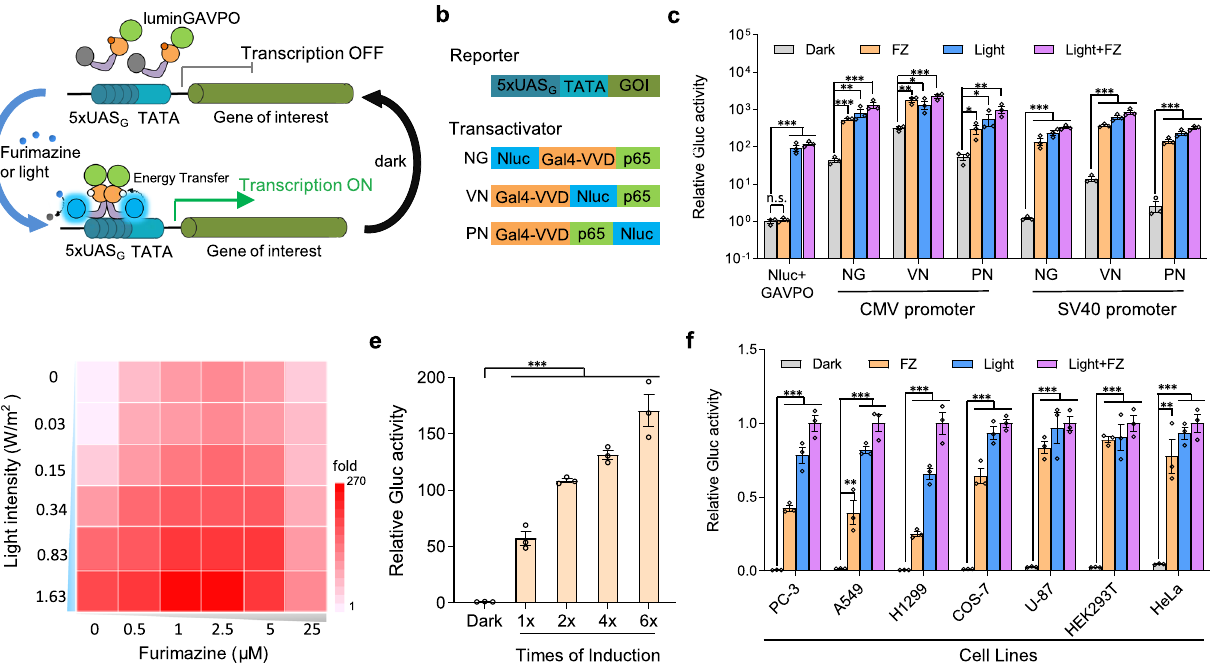
Fig. 1 Design and construction of the LuminON transgene expression system. a Schematic representation of the LuminON system. In the presence of furimazine or blue light, luminGAVPO homodimerizes, interacts with UAS G elements (5xUAS G ) and initiates transgene expression of the gene of interest (GOI). b Schematic representation of the reporter plasmid containing 5xUAS G upstream of the TATA box and the transactivator plasmids encoding different con fi gurations of Nluc-GAVPO fusion proteins. c Furimazine (FZ)- or blue light-induced Gluc expression by different con fi gurations of Nluc- GAVPO transactivators driven by the CMV or SV40 promoter. d Quantitative control of Gluc expression by modulating furimazine concentration and blue light intensity. The transfected cells were cultured with different furimazine concentrations (0 – 25 μ M) or light irradiances (0 – 1.63 W/m 2 ). Gluc activity was determined 24 h after induction, and induction ratios were calculated. e Gluc expression kinetics upon induction by furimazine for different durations. The transfected cells were induced by furimazine for different durations within 12 h, and Gluc activity was measured 24 h after the fi rst induction. Data were normalized to Gluc expression in the cells kept in dark conditions without induction by furimazine. f LuminON system-mediated Gluc expression in different mammalian cell types. Data were normalized to Gluc expression simultaneously induced by furimazine and external blue light. Data in ( c , e and f ) represent the mean ± s.d. from three technical replicates. All the statistical comparison was performed by two-tailed t test. n.s. means not signi fi cantly different, * P < 0.05, ** P < 0.01, *** P < 0.001. Source data are provided in the Source Data fi